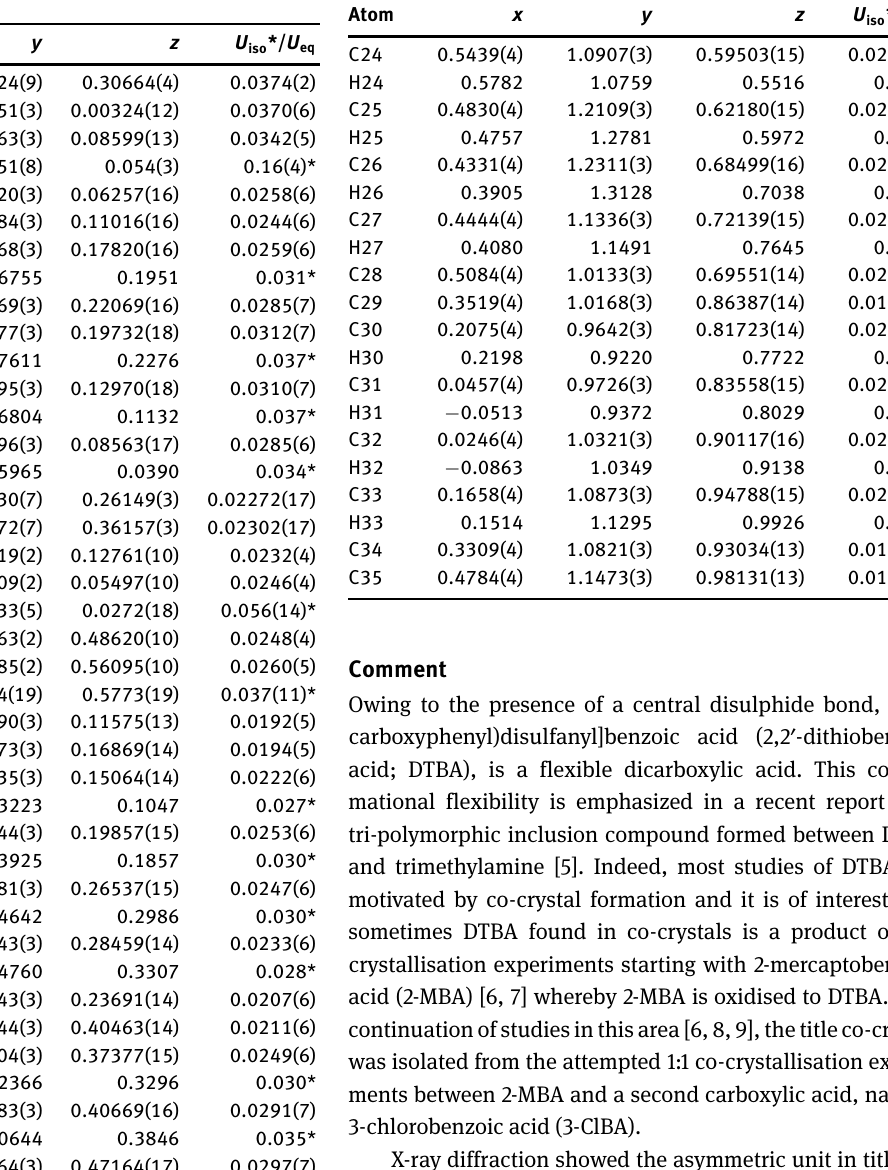
Table 2: Fractional atomic coordinates and isotropic or equivalent isotropic displacement parameters (Å 2